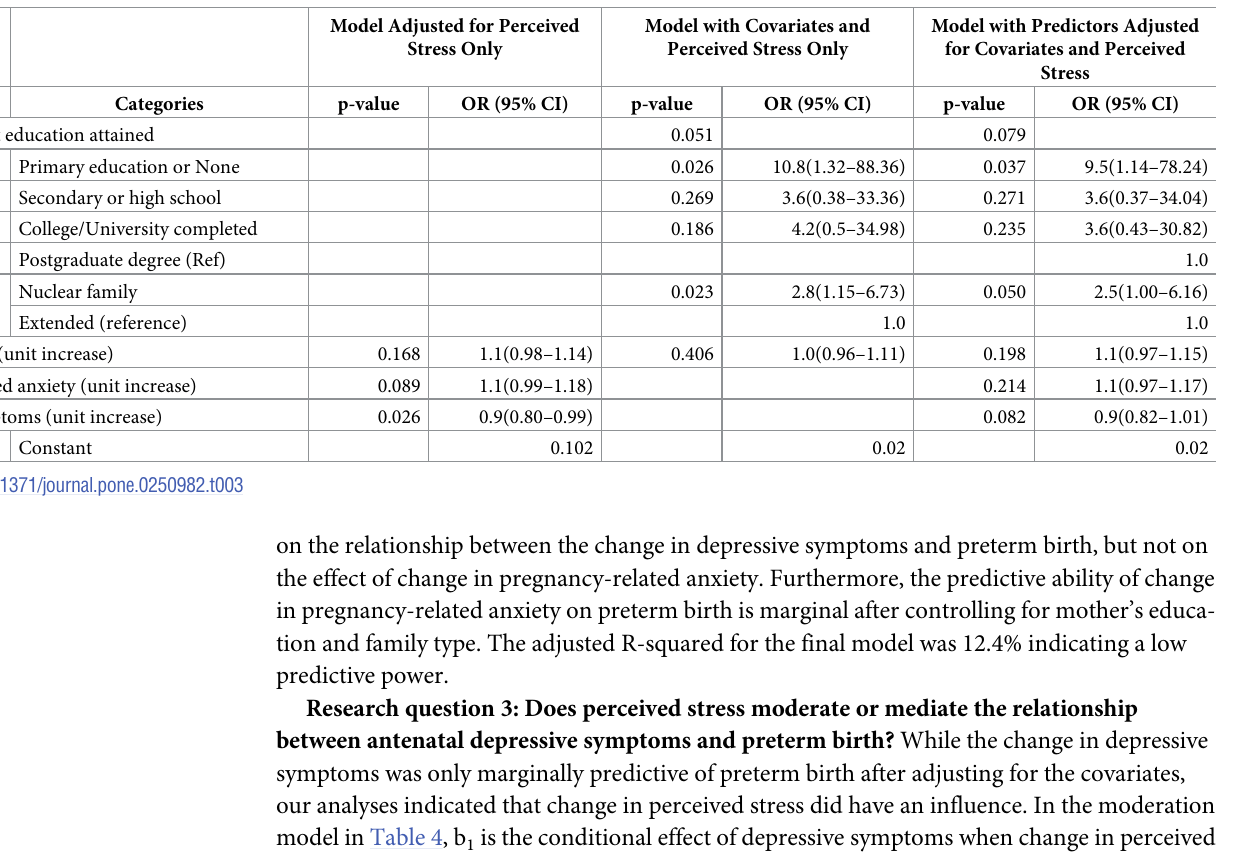
Table 3. Predictive model for preterm birth given changes in pregnancy-related anxiety and antenatal depressive symptoms during pregnancy adjusted for per- ceived stress.